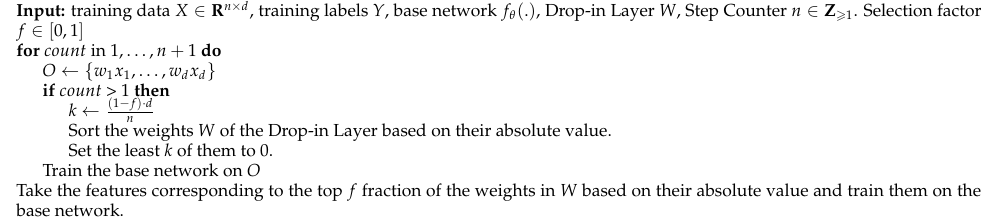
Algorithm 1 Original Stepwise Weight Pruning Algorithm (SWPA) [43]